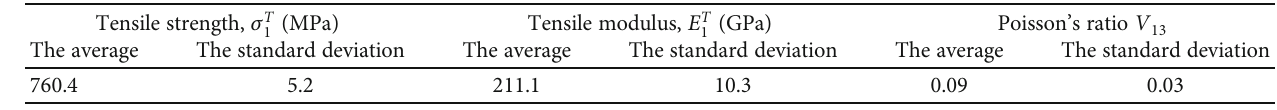
Table 1: Tensile properties of fi ber